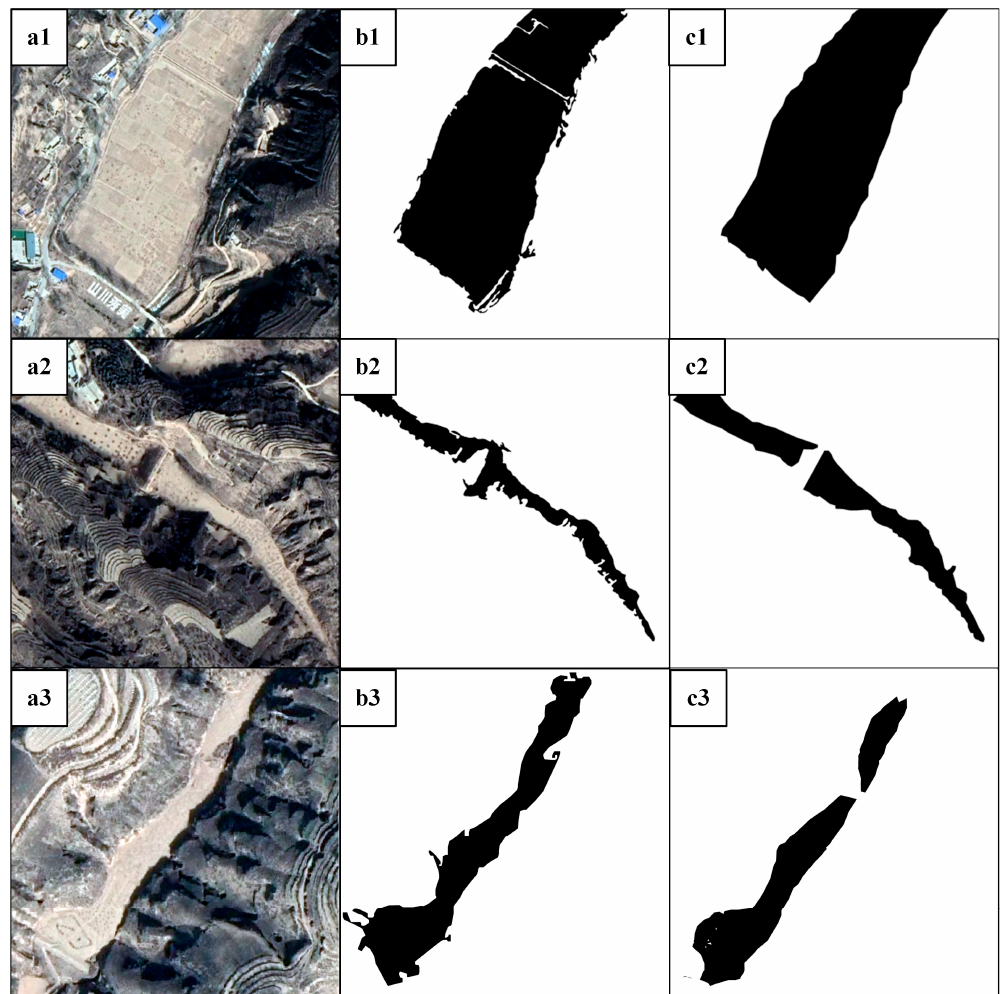
Figure 10. Results of the two extraction methods compared in terms of shape: ( a1 – a3 ) Google Earth remote sensing images; ( b1 – b3 ) the OBIA method’s results; ( c1 – c3 ) the proposed method’s results.